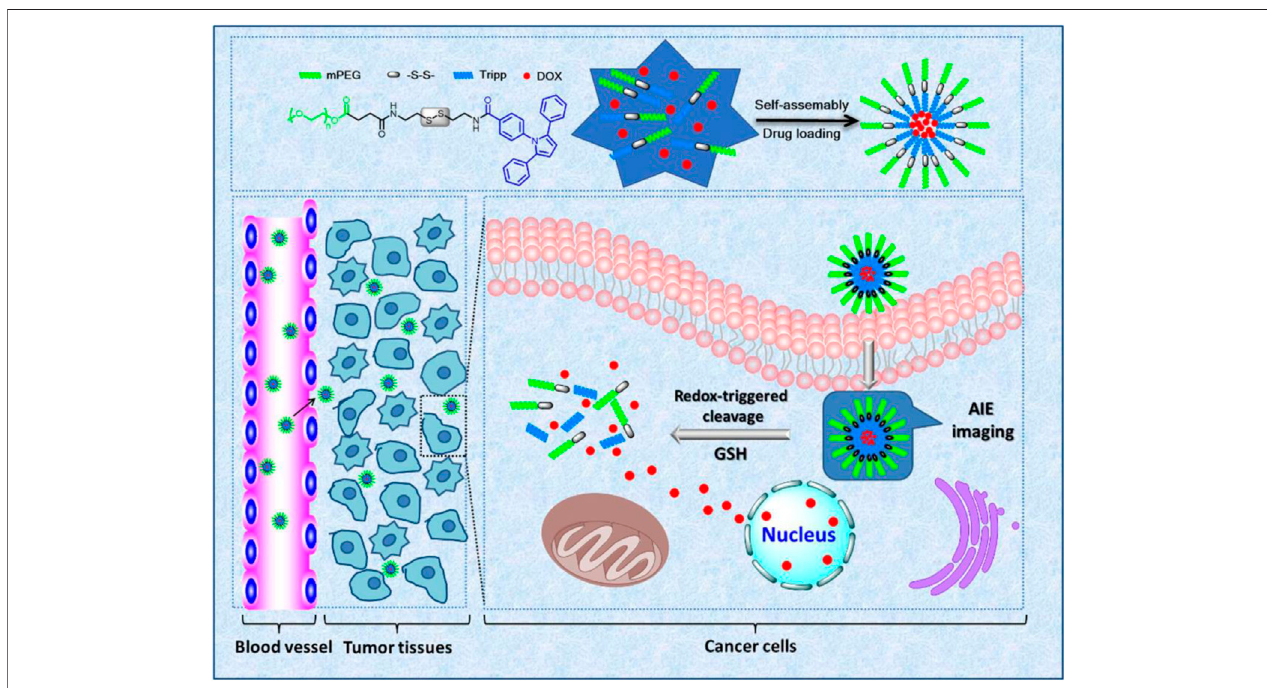
FIGURE 2 | | Malignant tumor cells are characterized by intracellular high concentrations of GSH. Advantage is taken from this in developing the redox-responsive drug delivery platform. Sun and colleagues explore redox-sensitive delivery platform (mPEG-ss-Tripp). Synthesized mPEG-ss-Tripp was loaded with doxorubicin via a disul fi de bond, which is sensitive to reductive substance GSH and then quickly cleaved through thiol-disul fi de exchange, in order to release the DOX at targeted sites without damaging normal tissues (Sun et al.,